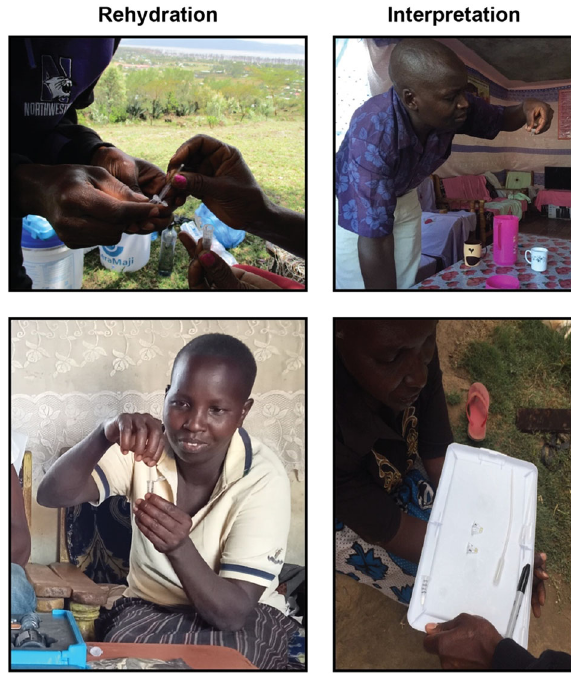
Fig. 3 Representative photographs of experiences with point-of- use fl uoride biosensor usability. The two key user activities for operating the tests are test rehydration, in which a micropipette is used to transfer a water sample into a microtubule (left) and result interpretation, in which the user ascertains if a yellow color has appeared